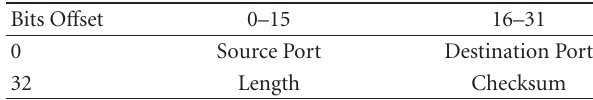
Table 2: UDP header.